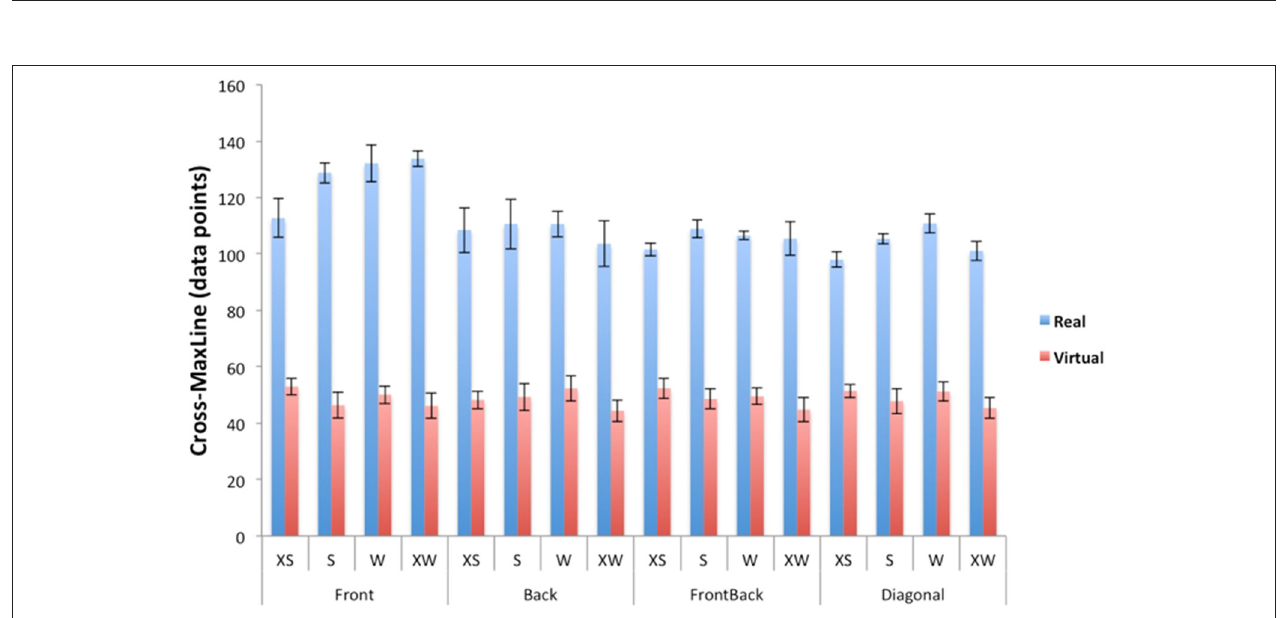
FIGURE 7 | Sample cross-recurrence plots for speed time series from a real (Left) and a virtual (Right) leader-follower dyad. Note the presence of a main diagonal line (i.e., line of synchronization) and the additional diagonal lines that are visible in the cross-recurrence plot for the real dyad. These are indicative of a temporally stable speed coupling between agents.